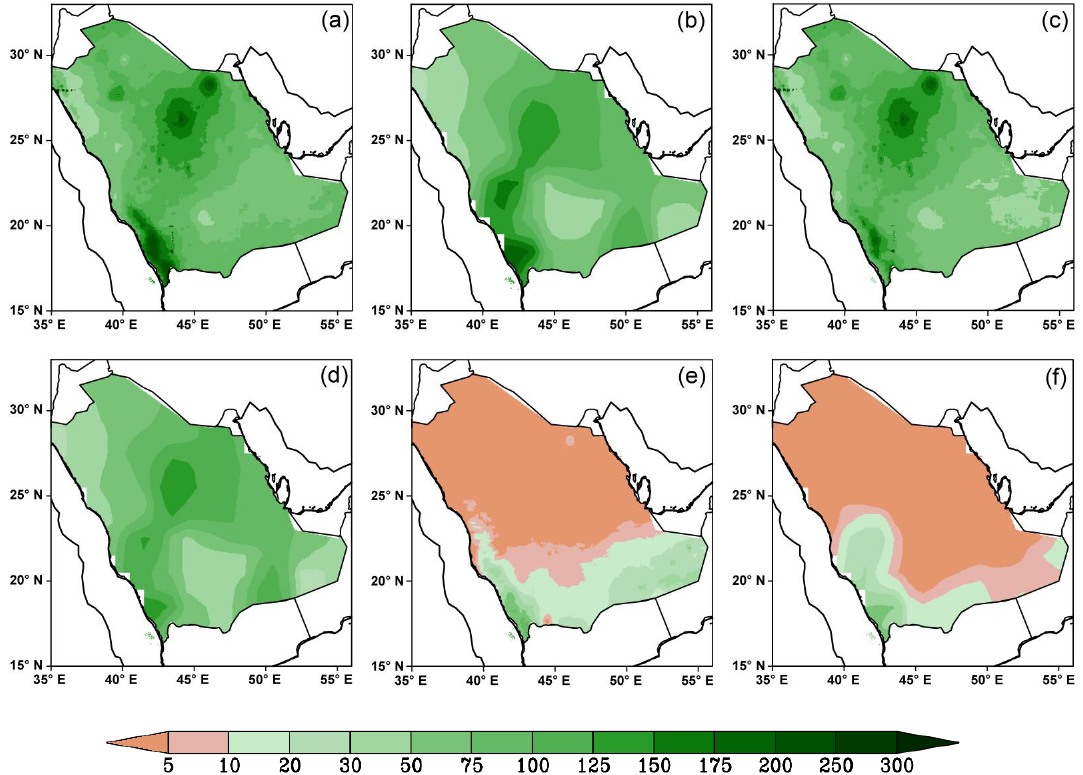
Figure 2. Spatial distribution of rainfall (mm) from CHIRPS ( a , c ) and GPCC ( b , d ) for the whole year ( a , b ), wet season ( c , d ), and dry season ( e , f ) in Saudi Arabia during the period 1981–2019.